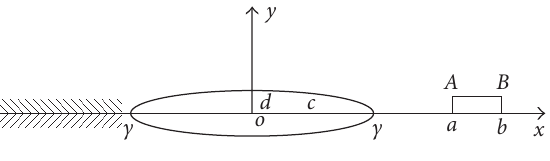
Figure 1.1. One charged strip in a plane with elliptic cavity.